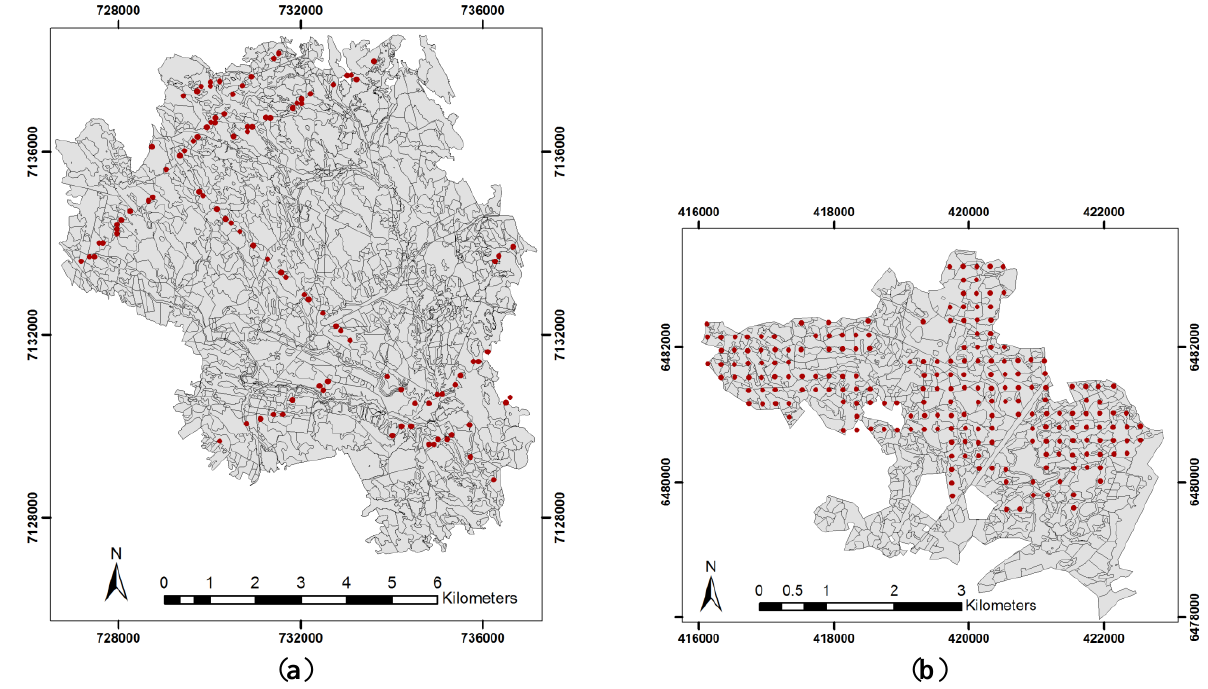
Figure 2. The forest stand delineation and field plot distribution of the two test